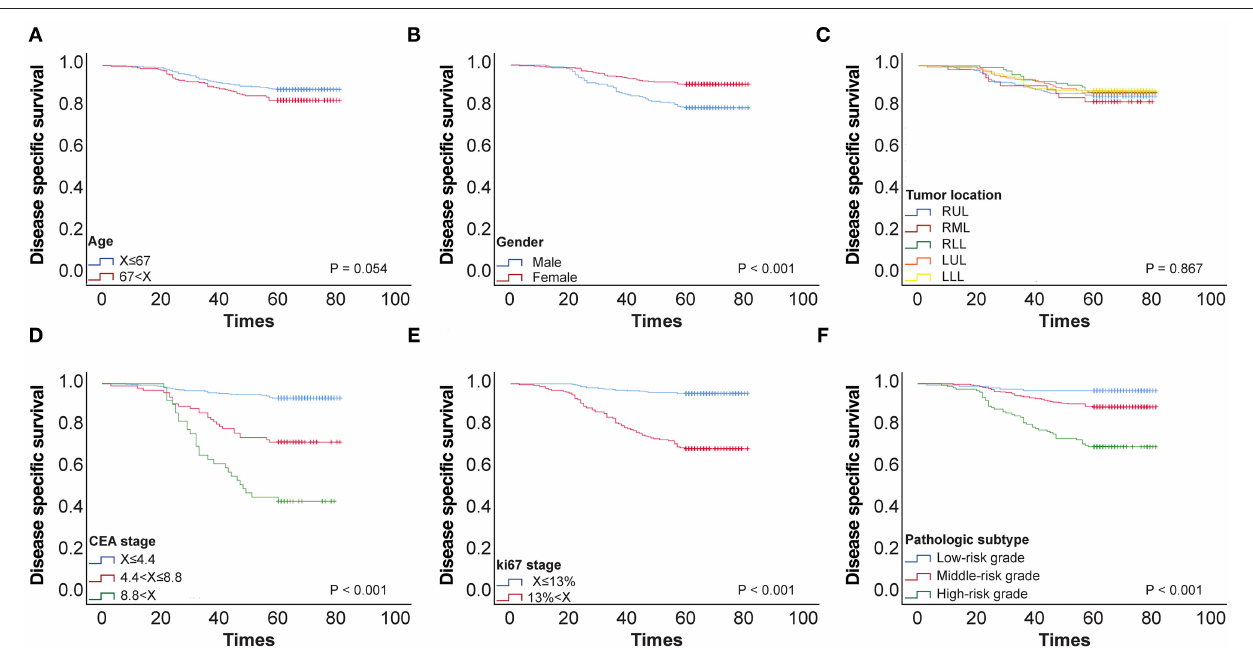
FIGURE 2 | (A) 5-y disease-specific survival (DSS) curve of 650 patients with stage I pulmonary adenocarcinoma according to age. (B) 5-y DSS curve of 650 patients with stage I pulmonary adenocarcinoma according to Gender stage. (C) 5-y DSS curve of 650 patients with stage I pulmonary adenocarcinoma according to Tumor